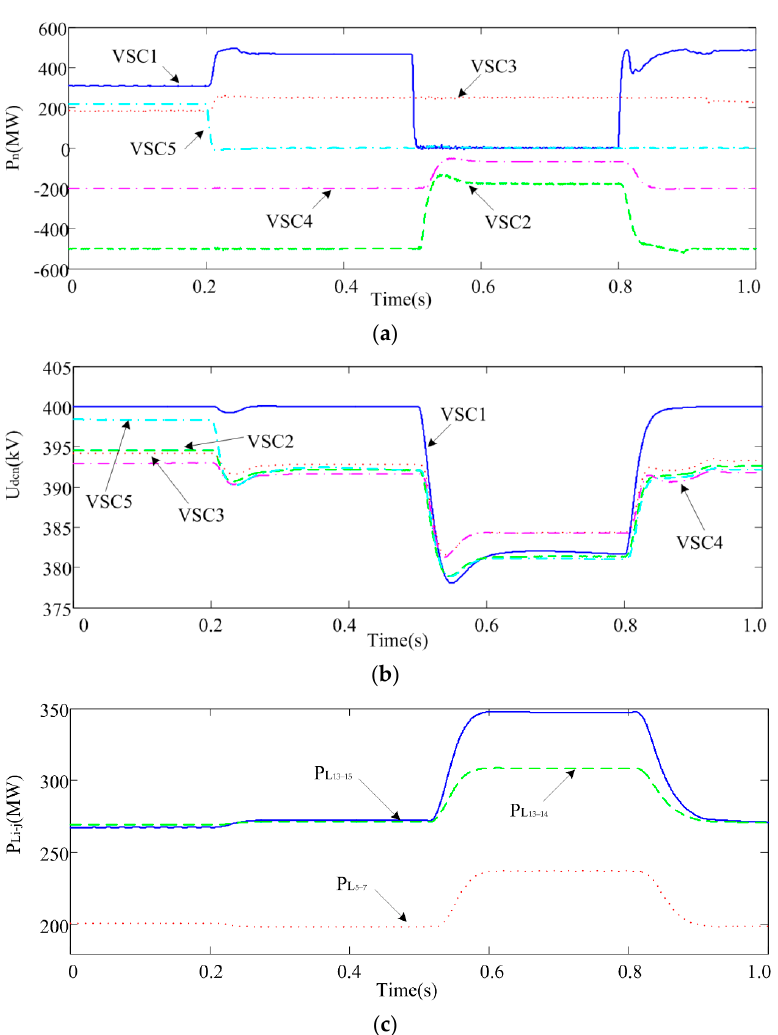
Figure 10. Simulation under shared control mode. ( a ) Active power of converters. ( b ) DC voltage of converters. ( c ) Active power of critical AC lines.